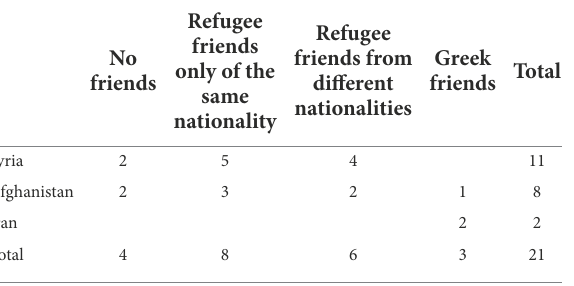
TABLE 1 Refugee children’s friendships and country of